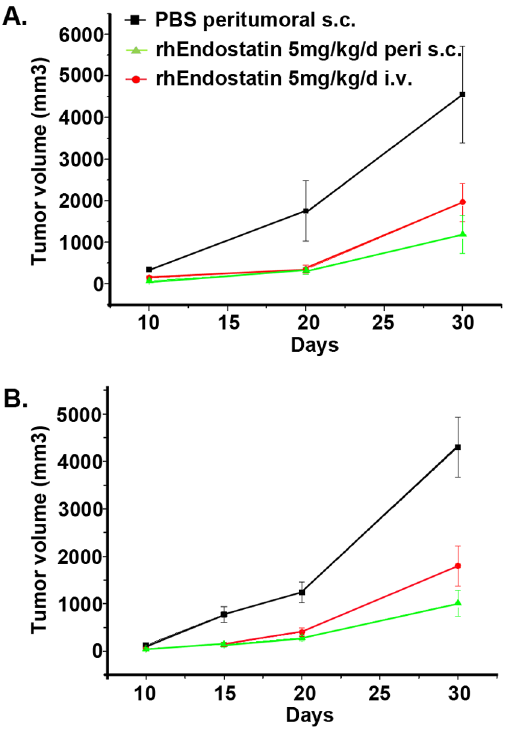
Figure 5. Inhibition of human tumor growth by administrating rhEndostatin s.c. peritumorally. Either A549 lung carcinoma cells (A), or Bcap37 breast cancer cells(B) were implanted to nude mice of 6 6 10 6 tumor cells each, subcutaneously. Tumor-bearing mice were then treated for successively 15 days with rhEndostatin (5 mg/kg/day) N ), or at the site close to the tumor ( m ). PBS was injected intravenously ( as the vehicle control at the site close to the tumor ( & ). Results were presented as mean 6 SD(n=10). Tumor volume was measured every other day, and the data indicated an enhanced reduction in tumor volume, when administered rhEndostatin s.c.